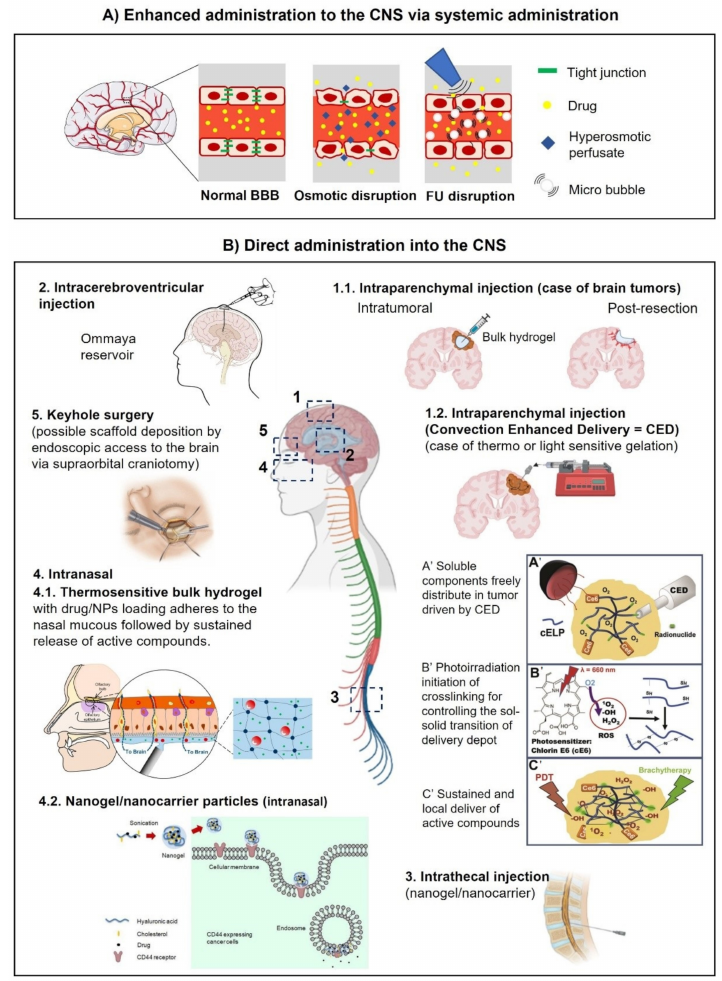
Figure 2. Routes of administration into the CNS. ( A ) Enhanced administration of molecules and nanobodies by osmotic or focused ultrasound (FU) disruption of the BBB. ( B ) Direct administration: 1.1. Intraparenchymal injection. A brain tumor case is schematized where hydrogel injection might be performed intratumorally or after resection around the cavity edges. 1.2. Intraparenchymal injection assisted by CED (convection-enhanced delivery). Depicted is the case where soluble compounds are evenly distributed by CED within the tumor before a gelation reaction is induced by photoirradiation. The resulting embedded gel can be used as a platform for the sustained release of active compounds [86]. 2. Intracerebroventricular administration of drugs directly into the cerebrospinal fluid (CSF). The Ommaya reservoir consists of a catheter connected to one lateral ventricle and a reservoir implanted under the scalp [91]. 3. Intrathecal injection. Lumbar puncture showing the direct administration of a drug directly into the CSF. 4. Intranasal delivery. 4.1 Intranasal application of modified HA in the nasal endothelium. Upon in situ polymerization the generated patch might be used as a reservoir for sustained release of compounds [62]. 4.2 After permeation of the nasal barrier, HA nanogels may be used to enhance intracellular trafficking of drugs in CD44 expressing cells [87]. 5. Keyhole surgery [43,90] might be used as an alternative access route to the implantation of hydrogels into the brain. Credits: Figure 2B-1.2: reprinted from Mukerji et al., 2022 [86], with permission from Elsevier. Figure 2B-2: reprinted from the public domain access at https://en.wikipedia.org/wiki/Ommaya_reservoir#/media/File:Ommaya_01.png (accessed on 5 October 2022) Lynch PJ. Figure 2B-4.1: reprinted from Kiparissides et al., 2022 [62], with permission from ACS. Figure 2B-4.2: reprinted from Wei et al., 2022 [87], with permission from ACS. Figure 2B-5: reprinted from Core Techniques in Operative Neurosurgery 2022 [91], with permission from Elsevier. Central and additional figures were created with